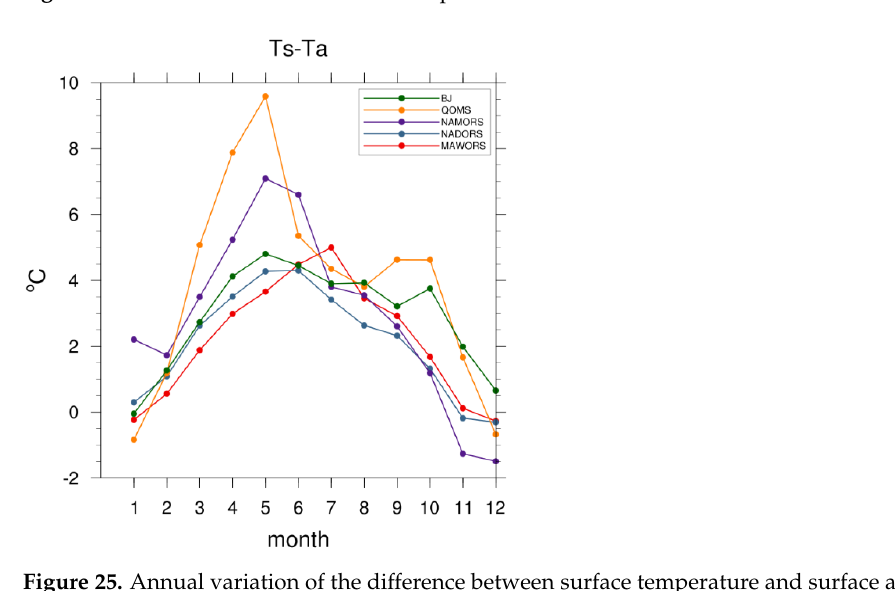
Figure 25. Annual variation of the difference between surface temperature and surface air temper- ature at each station.